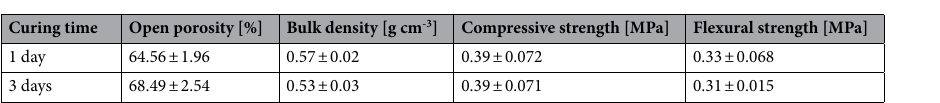
Table 1. Physical properties of the softener at different curing